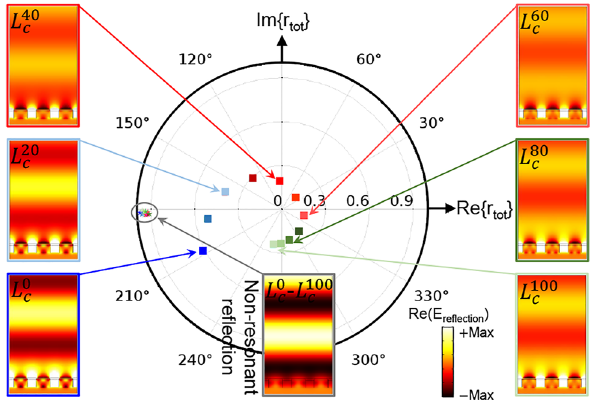
Figure 3: Polar plot representation for the trajectory of the total ) with increasing the GST complex reflection coefficient ( r tot , L c crystallization level. The condition of metasurface moves form the over-coupling for near-amorphous phase (bluish dots) towards the under-coupling state in the intermediate phases (reddish dots), and it again enters the over-coupling regime when the GST phase becomes close to crystalline (greenish dots). The non-resonant reflection responses accommodated in the center gray box confirm the negligible variation of both amplitude and phase for all crystallization levels (depicted with stars in the gray oval). To compare the phase shift between different GST crystallization levels, the corresponding electric field profiles of resonant and nonresonant reflected light are illustrated. L t c represents the crystallization fraction of t % for the GST nanostripe of each resonator (i.e., L 0 c and L 100 c correspond to the amorphous and crystalline phases,